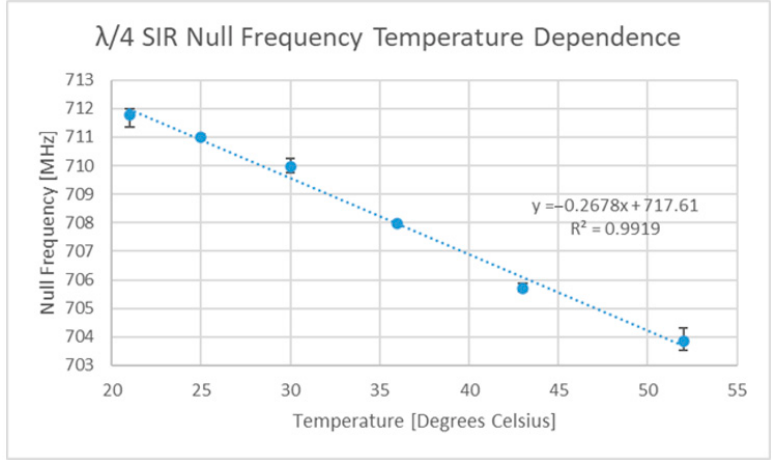
Figure 11. FR4 SIR circuit temperature sensitivity curve.